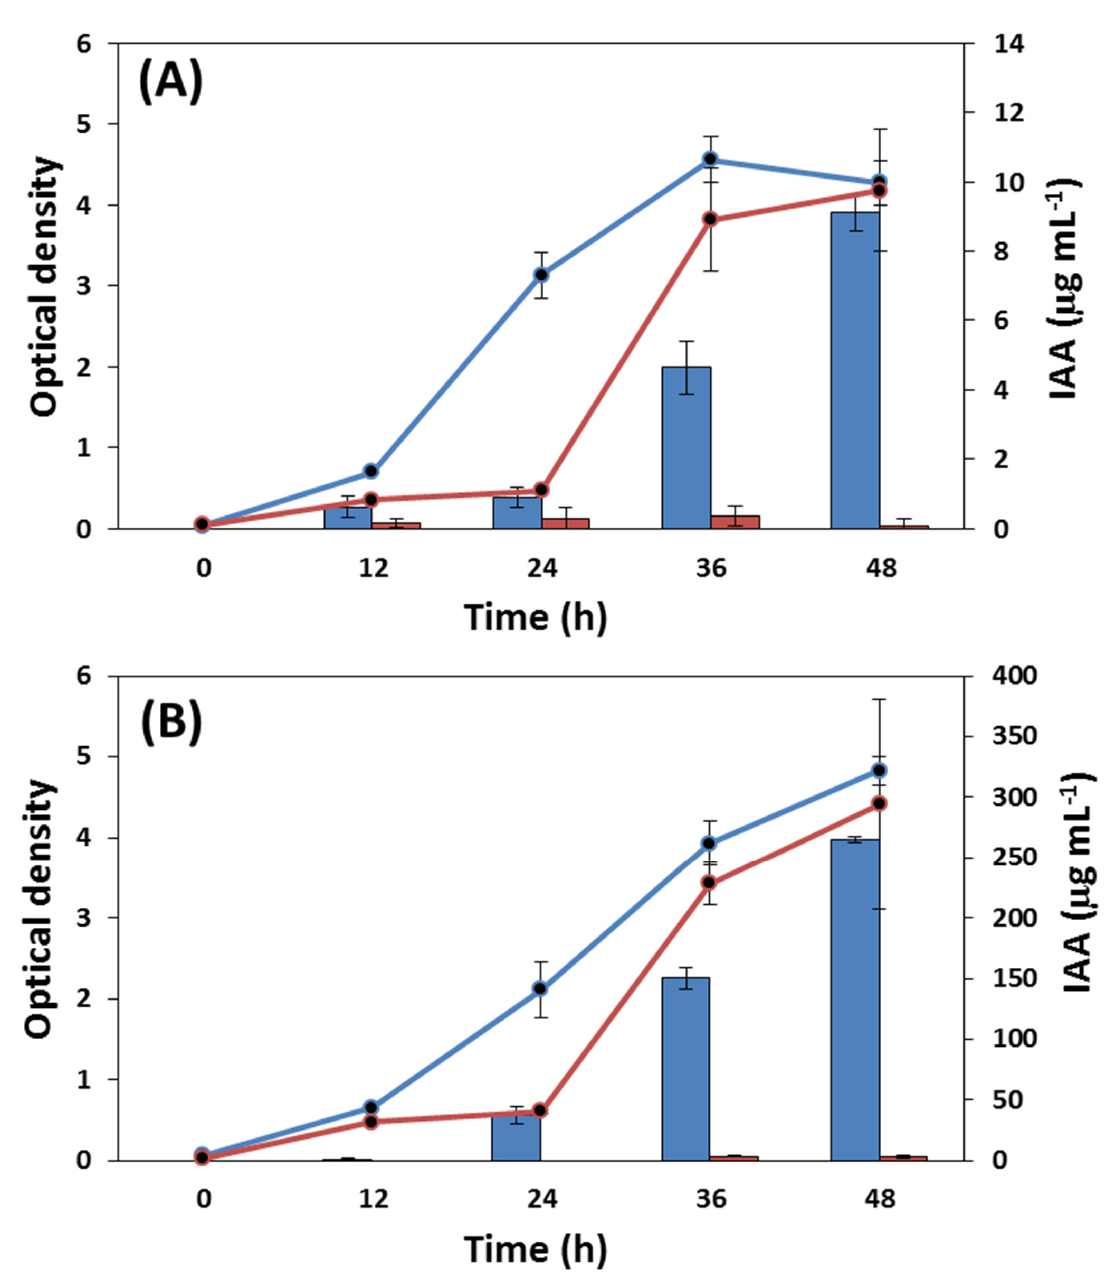
Figure 4. Growth (line) and exogenous IAA production (bar) by C. vulgaris was determined using potato dextrose broth medium (in blue) and molasses (in red), without ( A ) and with ( B) trypto- phan. Table 2. Statistical results of growth (optical density) of C. vulgaris in potato dextrose broth (PD) and molasses, with or without tryptophan, by Tukey’s test ( p < 0.05) 1 .